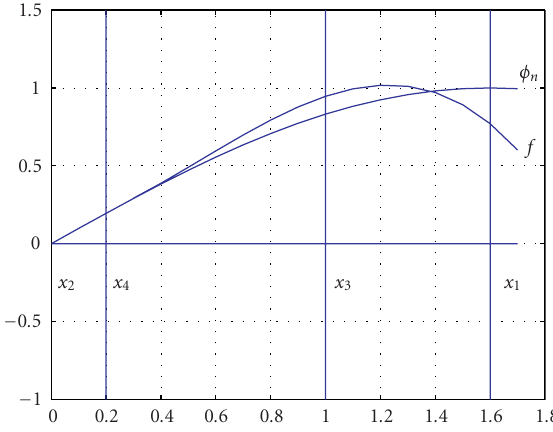
Figure 4.1. Construction for the proof of Theorem